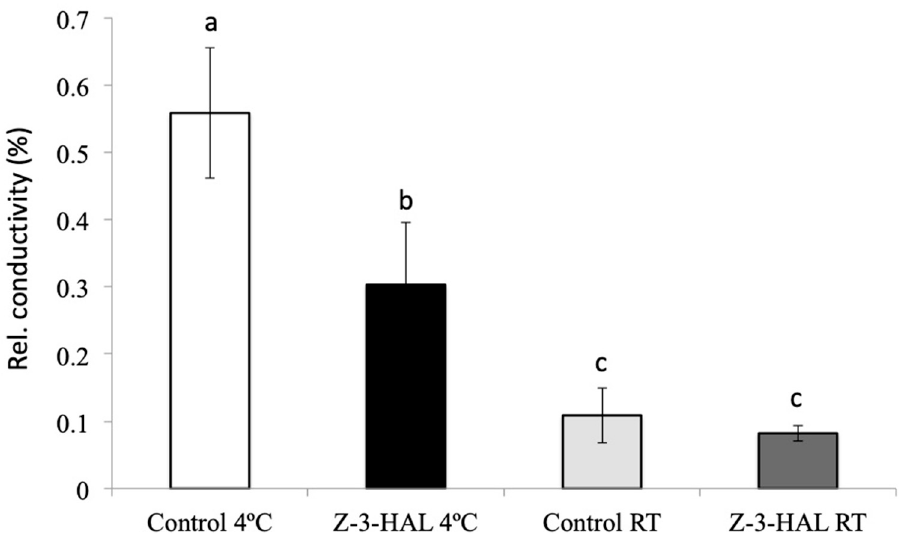
Figure 3. The effect of in-cold ( Z )-3-hexen-1-al (Z-3-HAL) treatment on cold stress related ion leakage in maize ( Zea mays ) seedlings ( n = 6). The relative conductivity is expressed as the ratio between ion leakage after short cold stress, divided by the total ion leakage after overnight freezing and thawing. The values are means ± SD, and different letters indicate significant differences between the treated and untreated seedlings (ANOVA, p < 0.05).